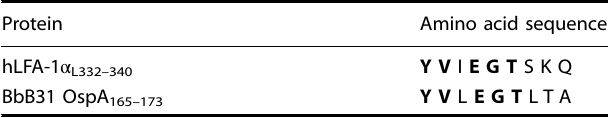
Table 1. Sequence homology between human fl eucocyte function associated Antigen-1 (hLFA-1) and B. burgdorferi native OspA. Protein Amino acid